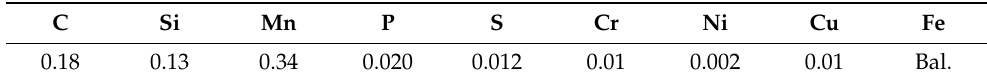
Table 1. The chemical composition of the Q235 substrate